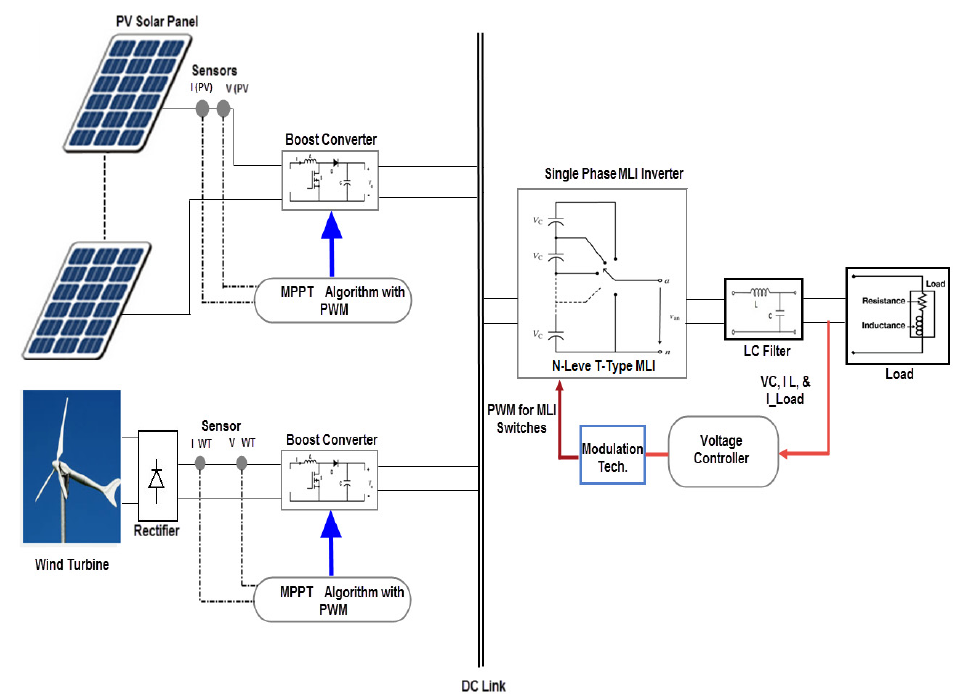
Figure 17. Voltage control for a T-MLI with a RES system.